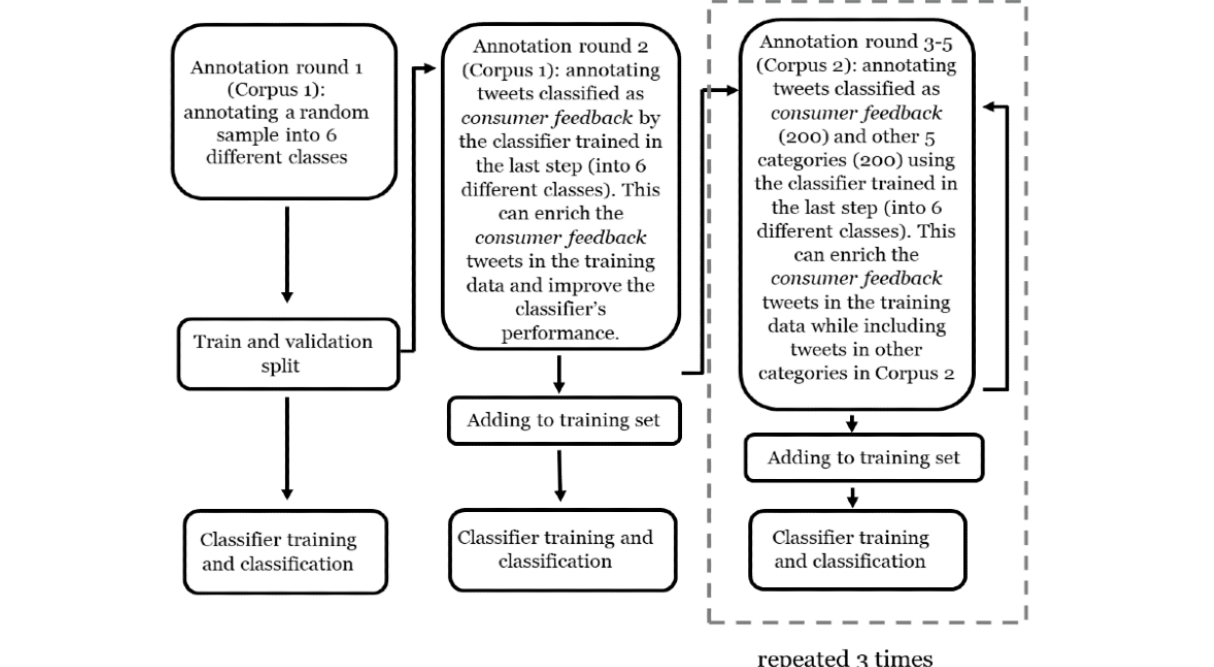
Figure 2. Flowchart for the entire annotation process (for the training and validation set) involving multiple